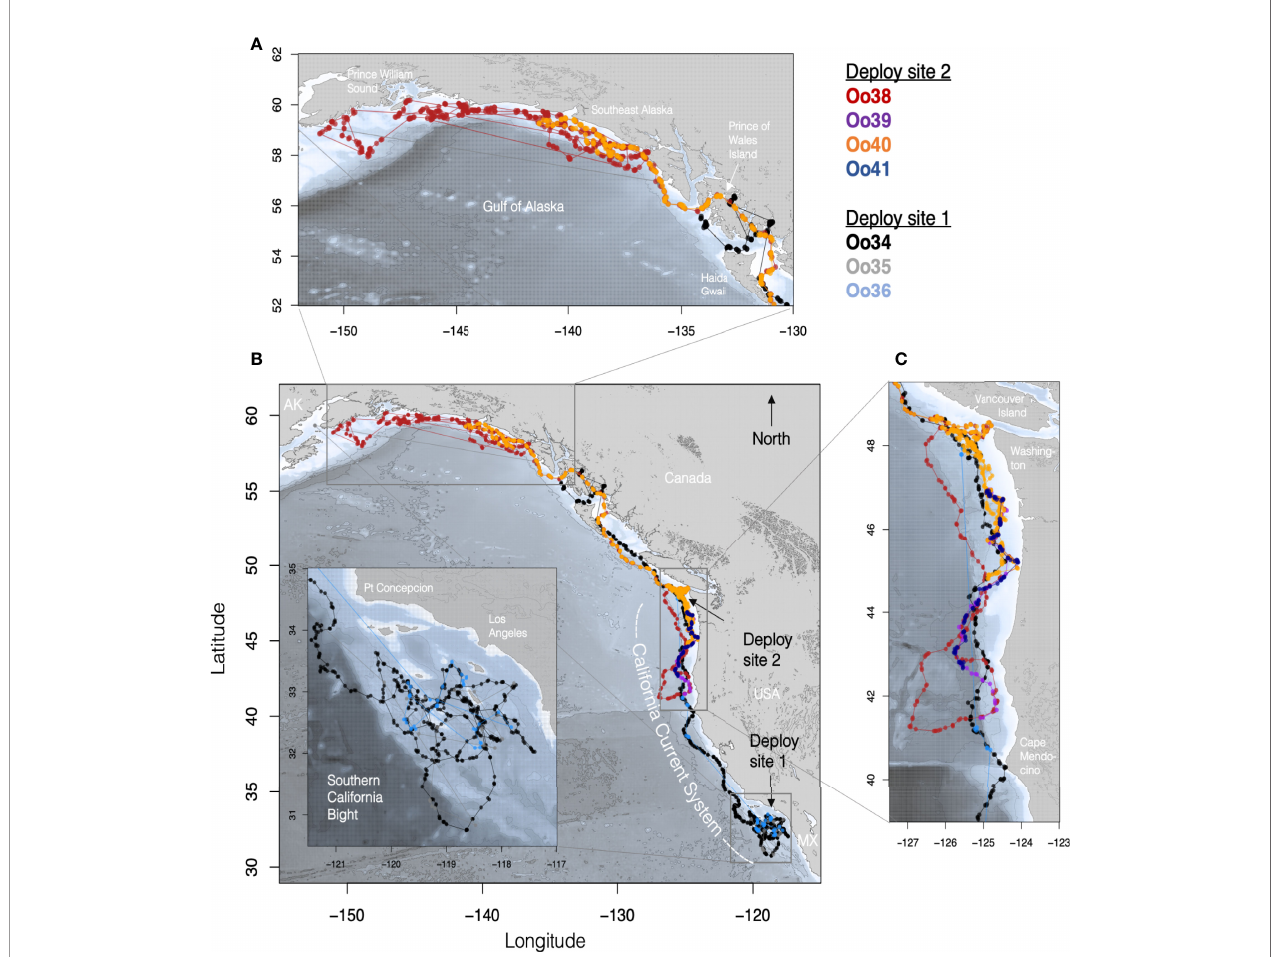
FIGURE 1 | Maps of tagged Offshore killer whale tracks with each Offshore killer whale assigned a different color. (B) shows the complete set of fi ltered Argos tracks for animals tagged in both California (Deploy site 1) and Washington (Deploy site 2). (Inset) details of movements within the Southern California Bight, with the deployment site being just west of the southernmost island (San Clemente). (C) Tracks of whales from southern British Columbia to northern Oregon with the deployment site off the coast of WA indicated by the black arrow. (A) Track details of the movements within the Gulf of